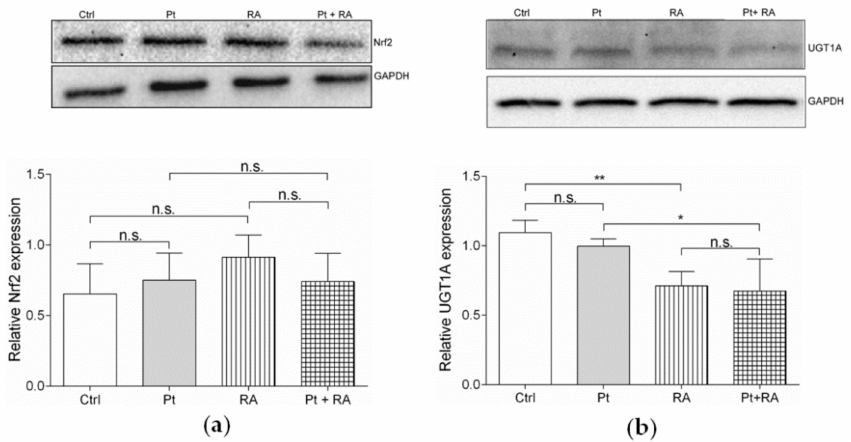
Figure 8. Representative Western blots and the corresponding densitometric quantification (mean ± SEM, n = 3) of ( a ) the relative Nrf2 expression and ( b ) the relative UGT1A expression in the transfected untreated SKOV-3 cells (Ctrl), after exposure to 15 µ M cisplatin (Pt), to 20 µ M retinoic acid (RA) and after co-incubation with 20 µ M retinoic acid and 15 µ M cisplatin (Pt + RA) for 24 h are shown. GAPDH was used as a loading control. * p < 0.05, ** p < 0.01, n.s. = not significant.